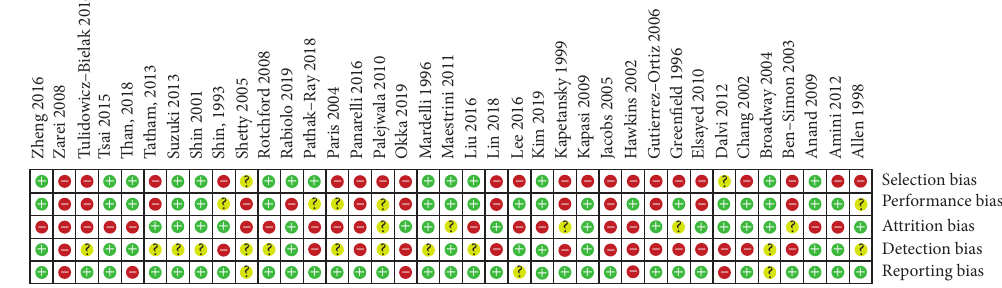
Figure 2: Summary of risk of bias assessment for each selected case.